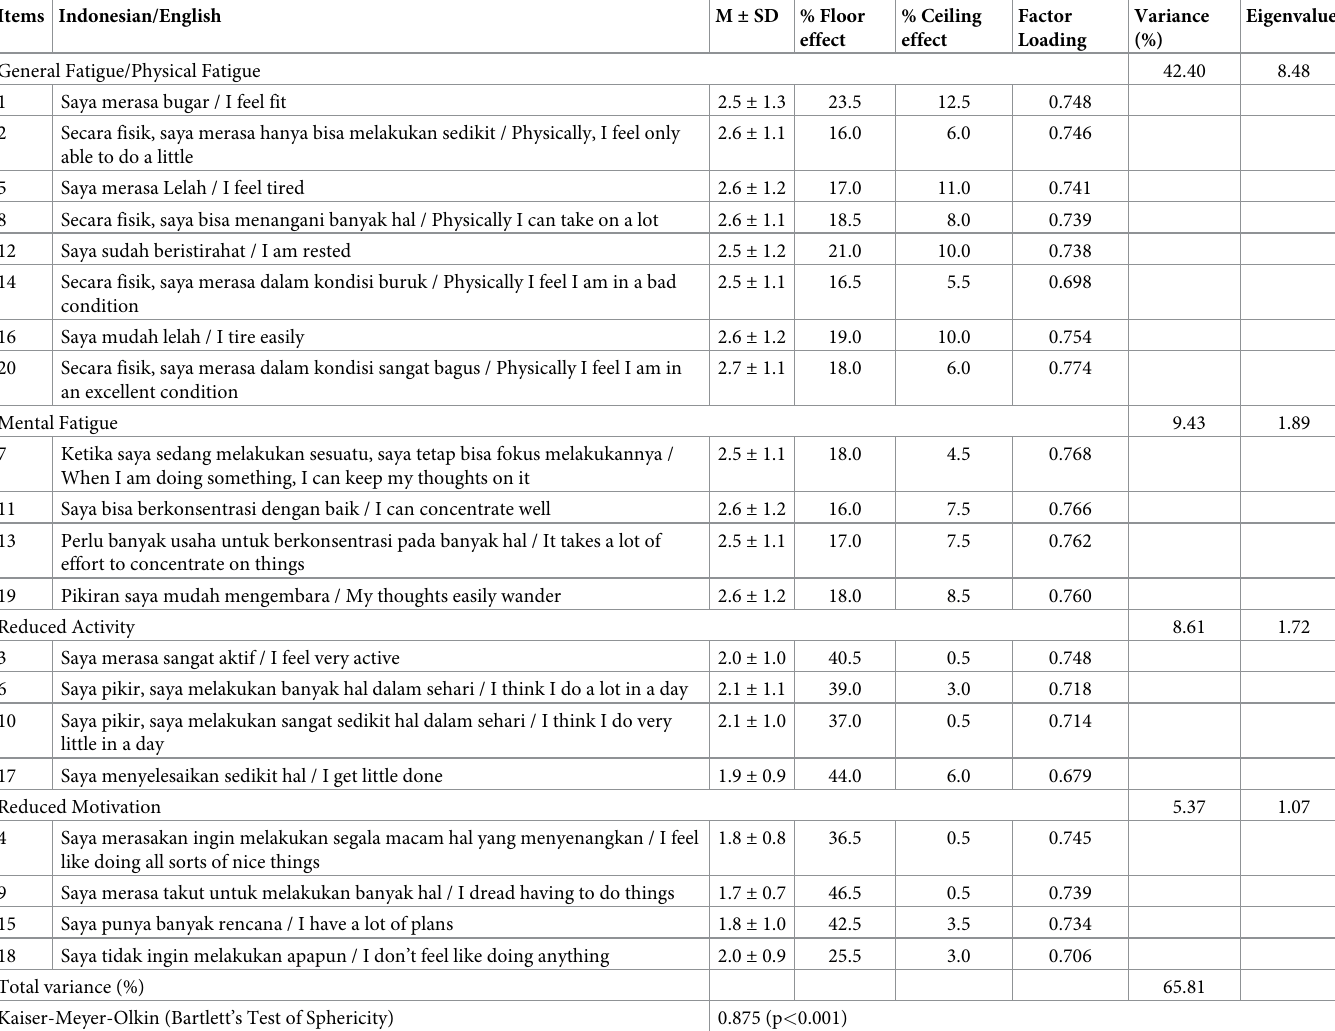
Table 3. Exploratory factor analysis of the IMFI-20. Items Indonesian/English